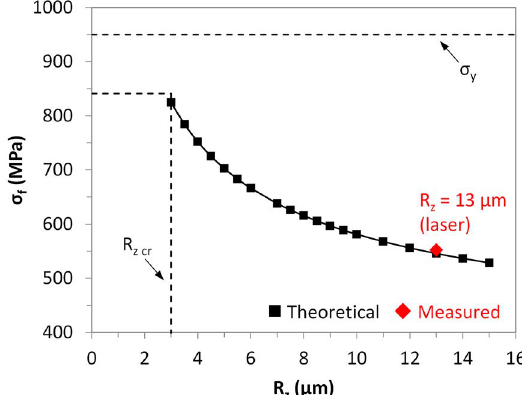
Figure 6. Curve of fatigue limit (σf) in function of roughness [11]. The result of the present work was indicated as “measured”.